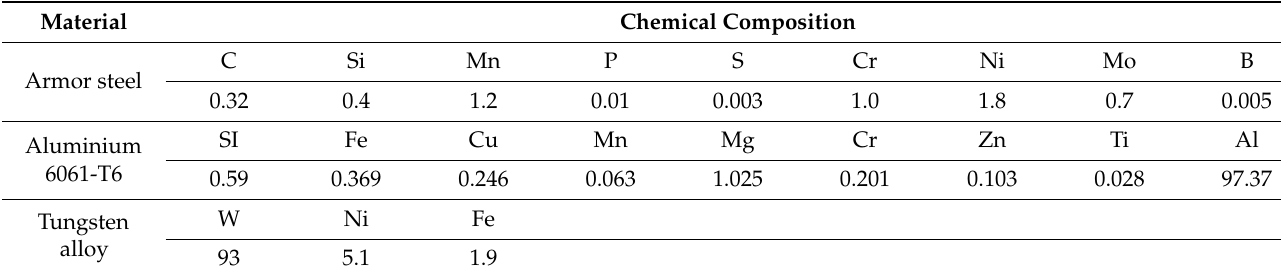
Table 2. Chemical composition of materials (in wt